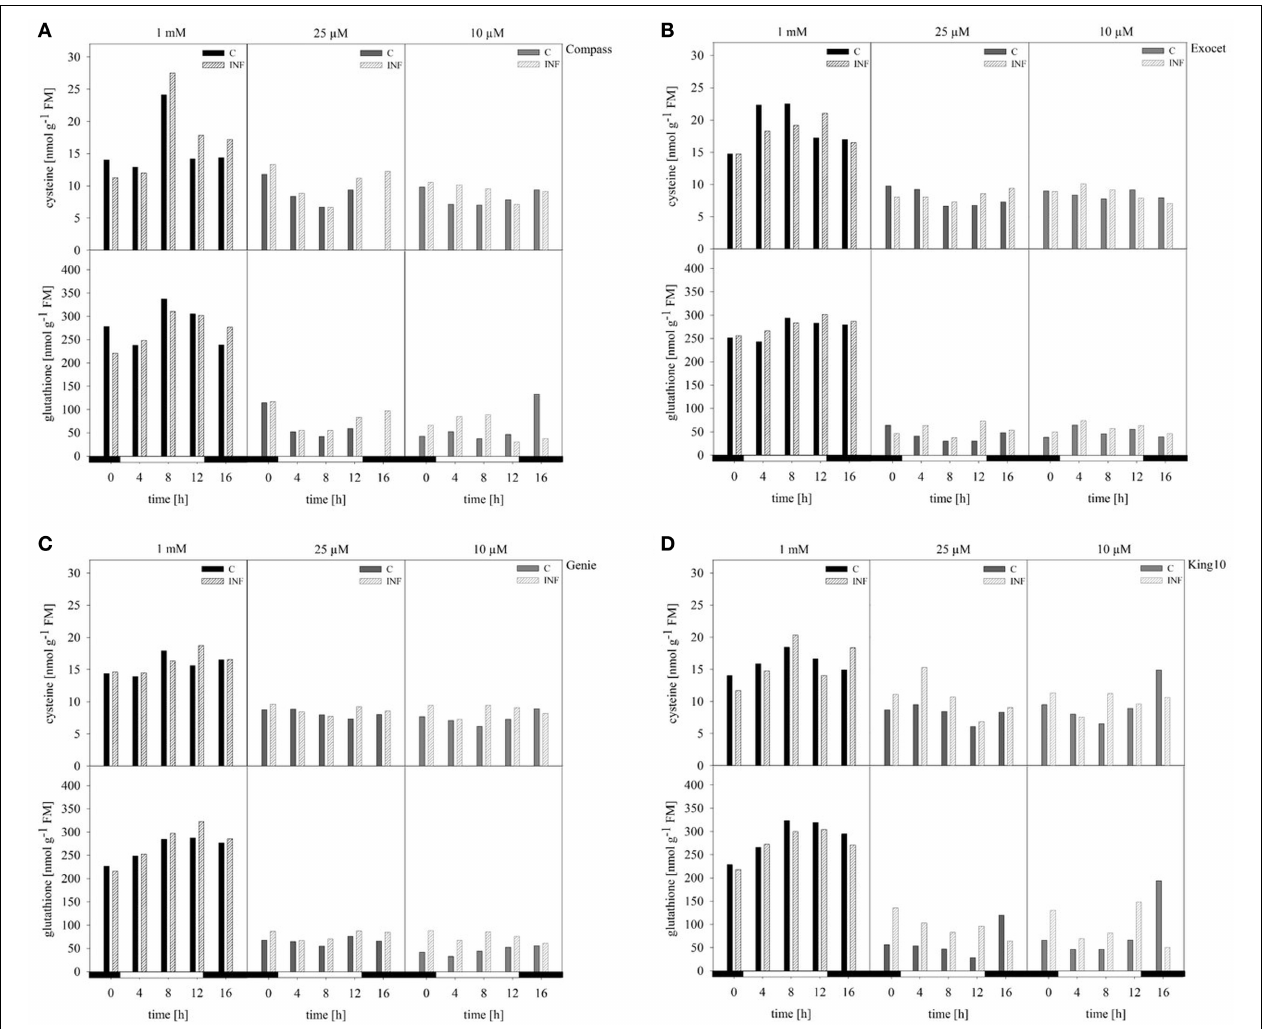
FIGURE 7 | Thiol contents. The cysteine and glutathione contents were determined in plants (five leaves fully expanded) treated and collected as described for Figure 5 by HPLC. The thiol contents were calculated in nmol